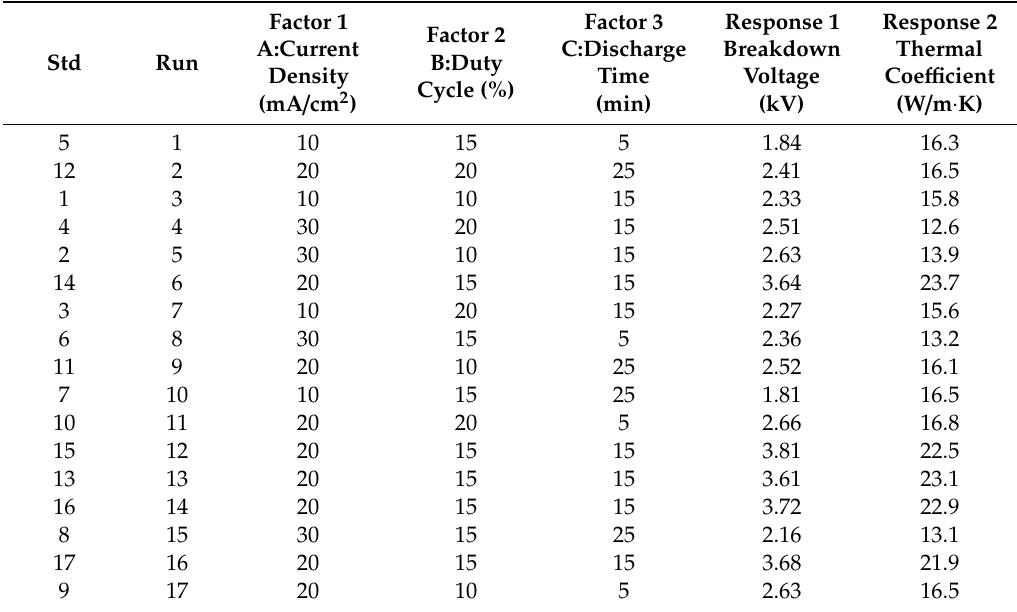
Table 7. Experimental factors and results of BOX-Behnken design